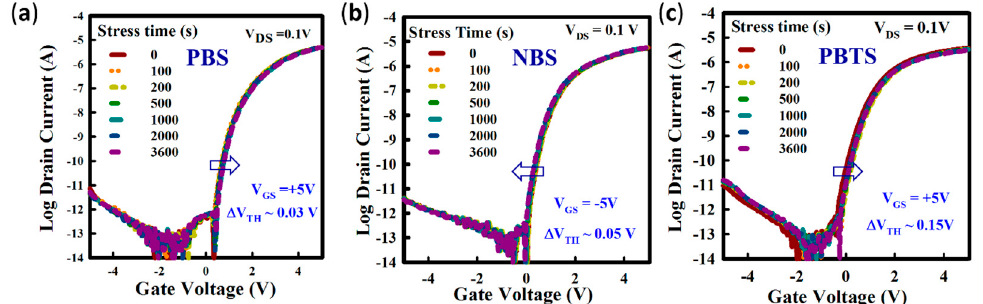
Figure 6. The evolution of transfer curve under bias stress for the ZnO TFTs with Y 2 O 3 passivation. Transfer curves of ZnO TFTs under ( a ) positive bias stress (PBS), ( b ) negative bias stress (NBS), and ( c ) positive-bias-temperature-stress (PBTS) at 60 °C. Thetransfer curve of the TFT measured by sweeping V GS from − 5 to +5 V at the drain voltage, V DS = 0.1 V for 1 h.